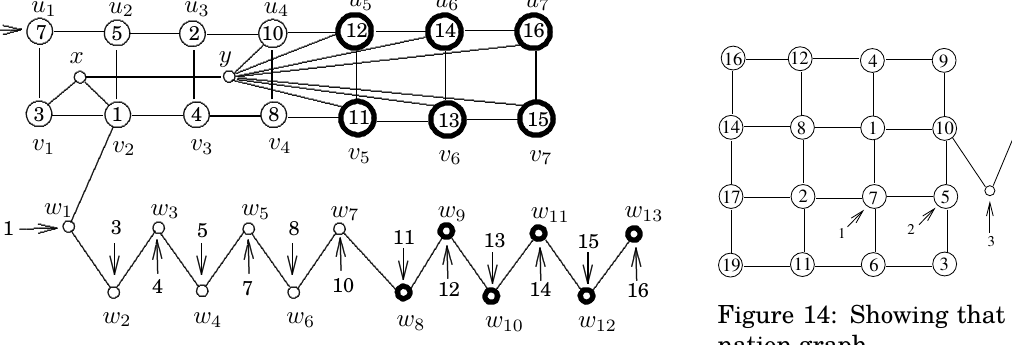
Figure 13: The graph G